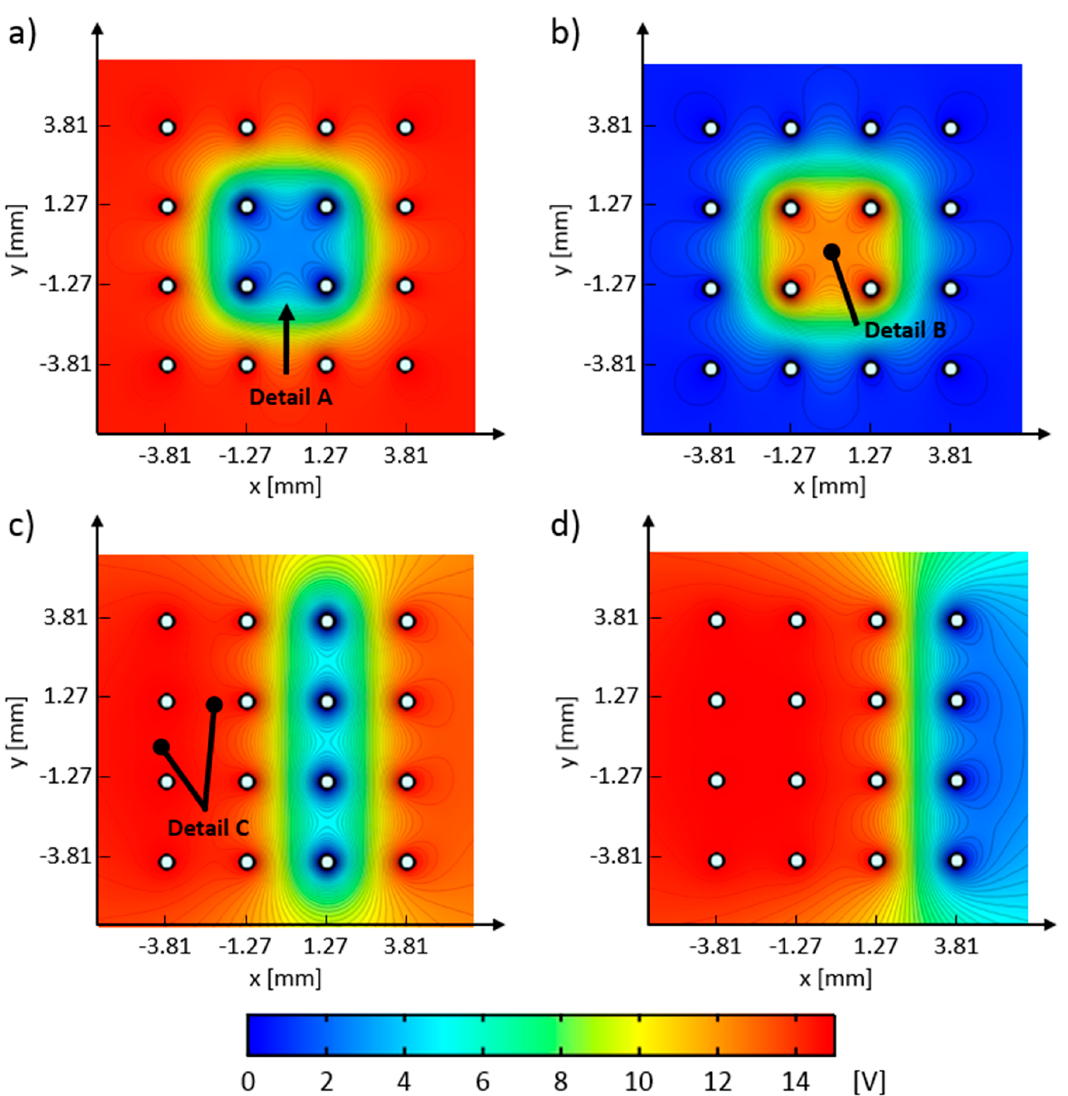
Figure 11. FEM computed electric potential distributions for control schemes A–D. ( a ) Computed potential distribution for focusing, control scheme A; ( b ) computed potential distribution for defocusing, control scheme B; ( c ) computed electric potential distribution for translating particles to the 3rd array column, control scheme C; ( d ) computed electric potential distribution for translating particles to the 4th array column, control scheme D. The color bar shows the range of the applied electric field from 0 V (blue) to 15 V (red). Readers are referred to the color version of the picture.